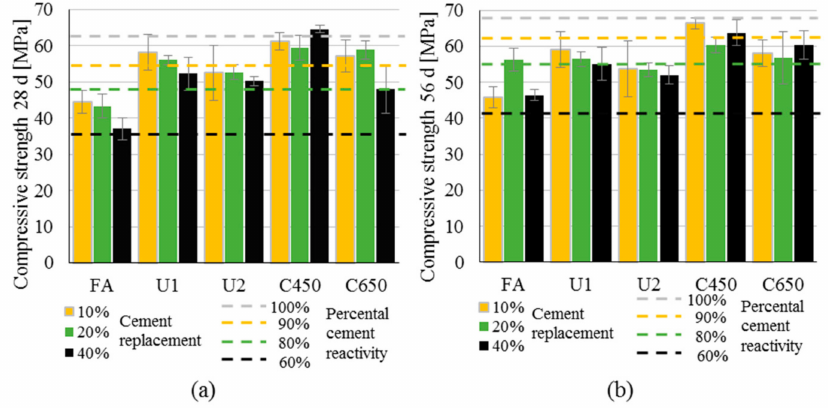
Figure 7. Compressive strength values after ( a ) 28 days and ( b ) 56 days for all test